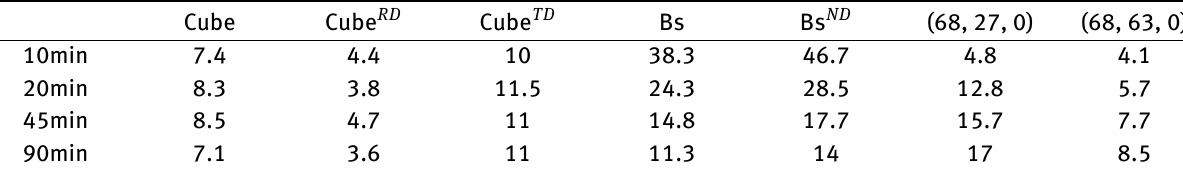
Figure 9: Micro-texture evolution of the CCR processed nickel during in-situ annealing at 550 ∘ C for (a) 10 min, (b) 20 min, (c) 45 min and (d) 90 min. Table 3: Volume fraction (%) of texture components during in-situ annealing at 550 ∘